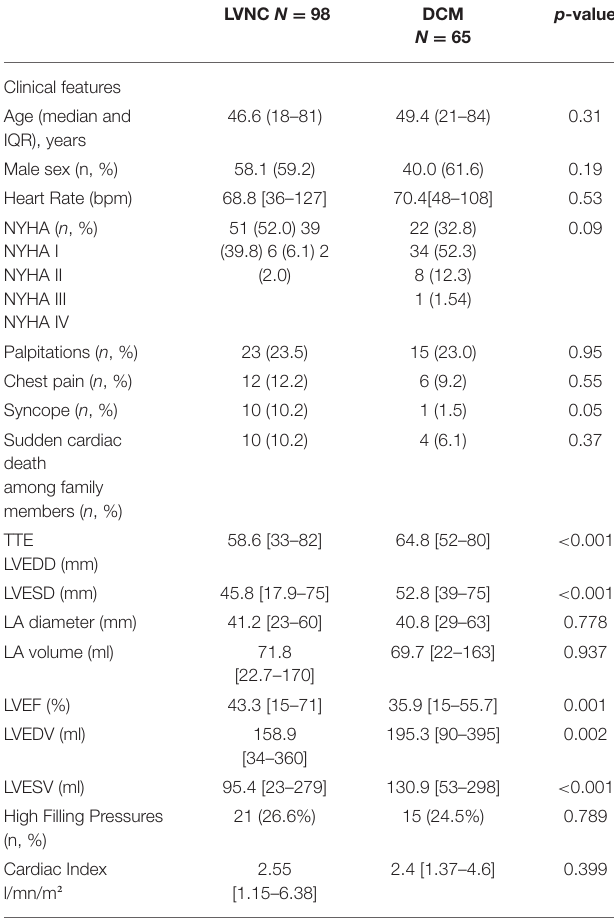
TABLE 1 | LVNC and DCM clinical and echocardiographic characteristics at